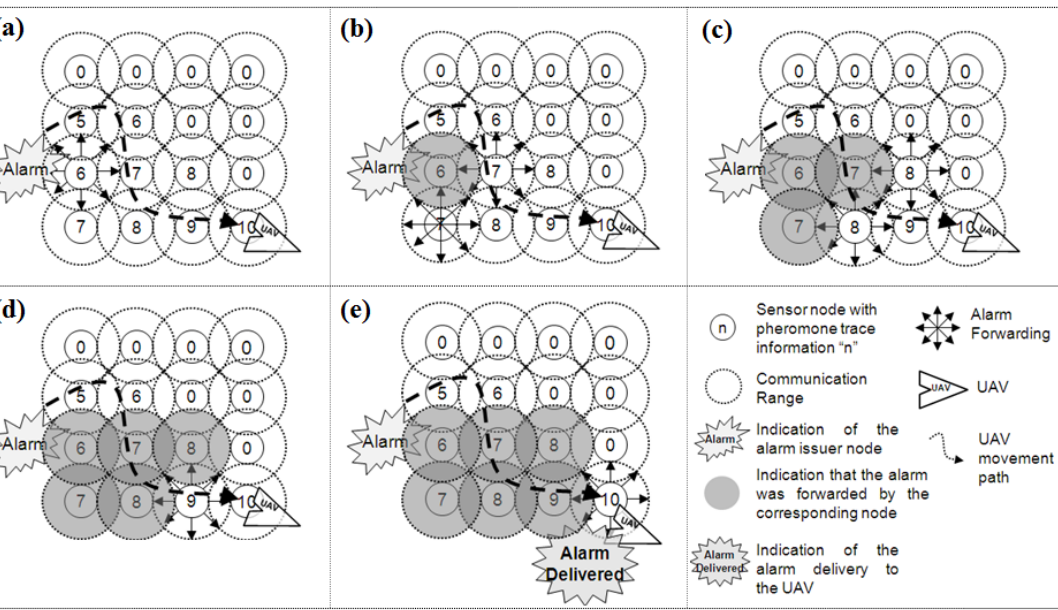
Figure 5. Trail-follow mechanism example used in the pheromone-based alarm delivery step by step from the alarm issuing towards its delivery: ( a ) Alarm issue; ( b ) Alarm propagation closer the alarm issuer node; ( c ) Alarm propagation proceeding; ( d ) Alarm propagation getting closer to the nodes in the range of the UAV; ( e ) Alarm